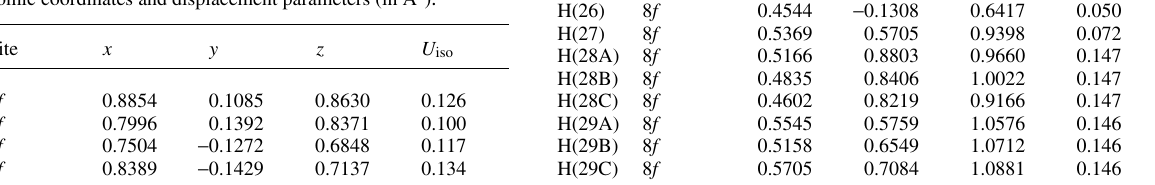
Table 2. Atomic coordinates and displacement parameters (in Å 2 ) .